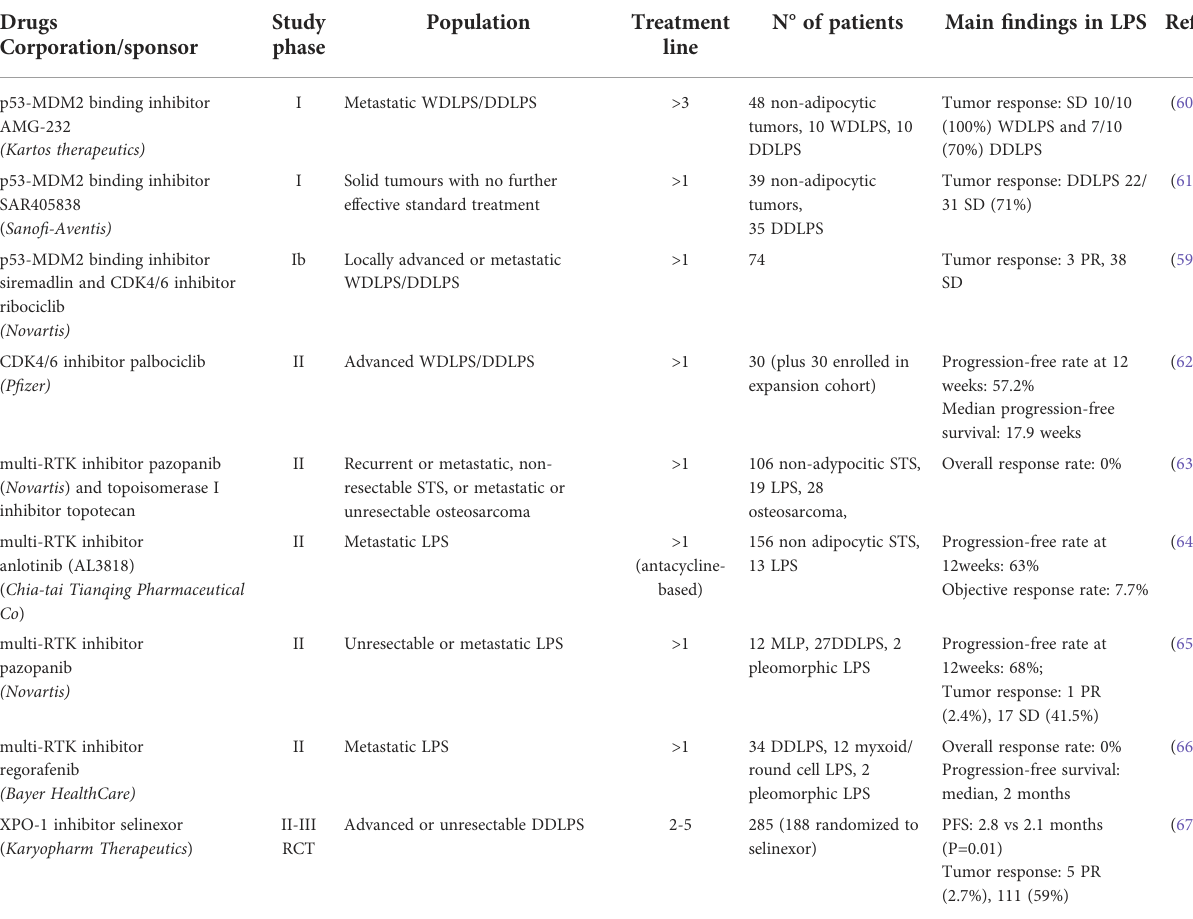
TABLE 2 Summary of results from clinical trials that tested innovative treatment options for patients with metastatic WDLPS and